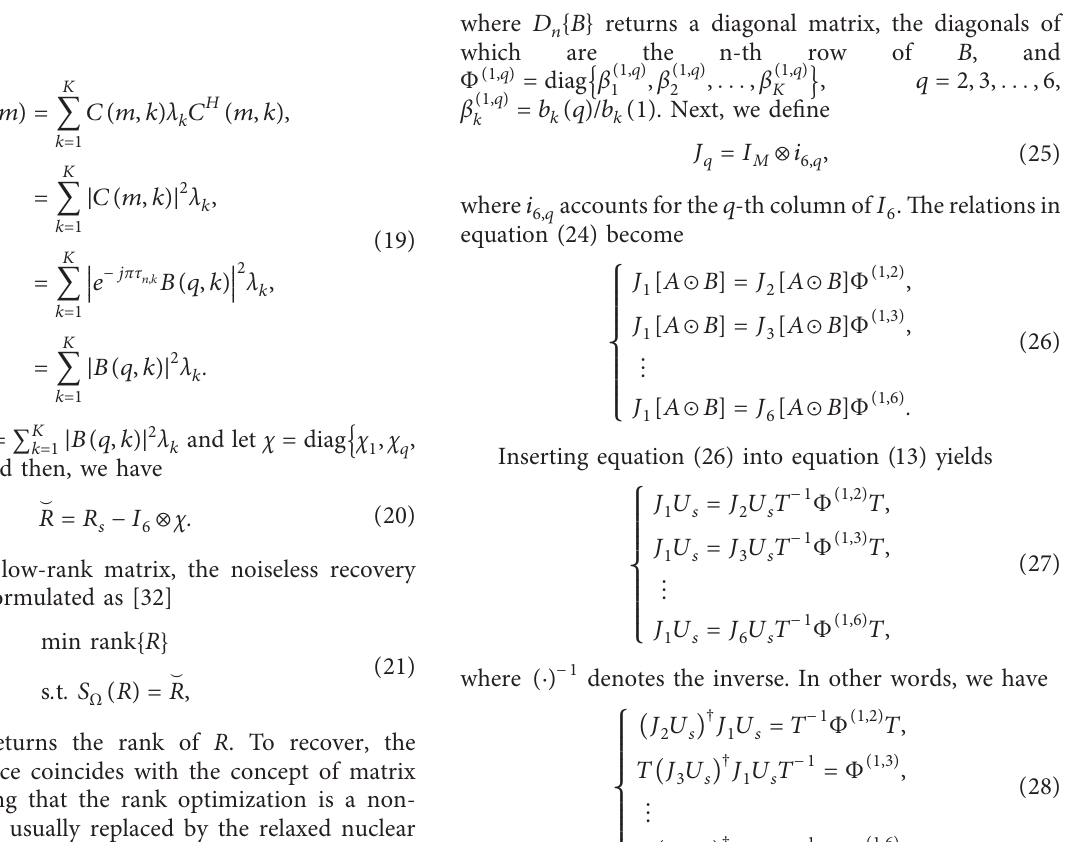
Figure 1: Illustration of the proposed denoising